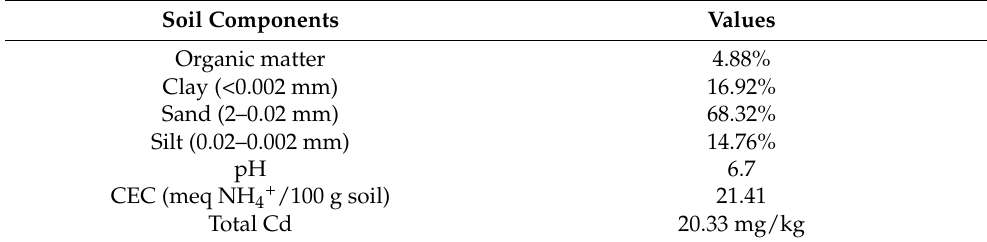
Table 2. Basic properties of the studied soils collected from